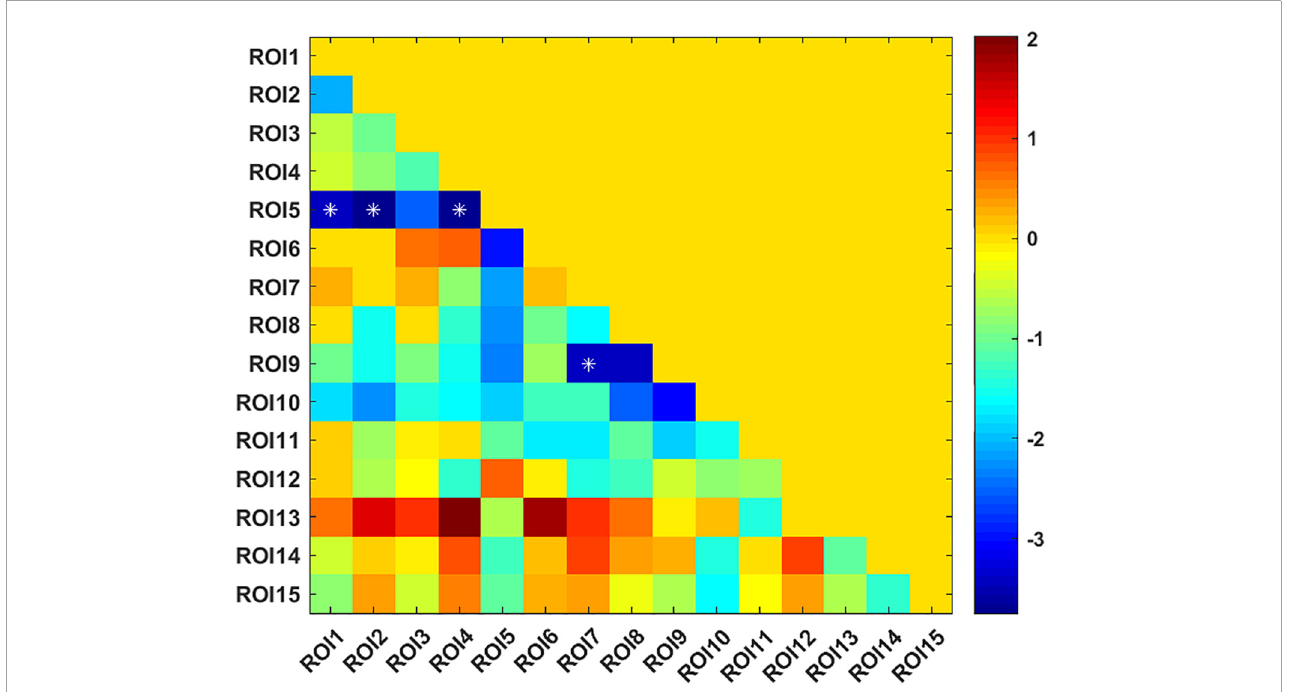
FIGURE3 T -value matrix of functional connectivity between the Parkinson’s disease (PD) and healthy controls (HC) groups. 4 ROI-pair significant FCs (marked as ∗ ) from the lower triangular part of the matrix were retained (redundant elements and diagonal elements were excluded) in a 15 × 15 matrix, namely, the ROIs with significant correlation between DC and uric acid